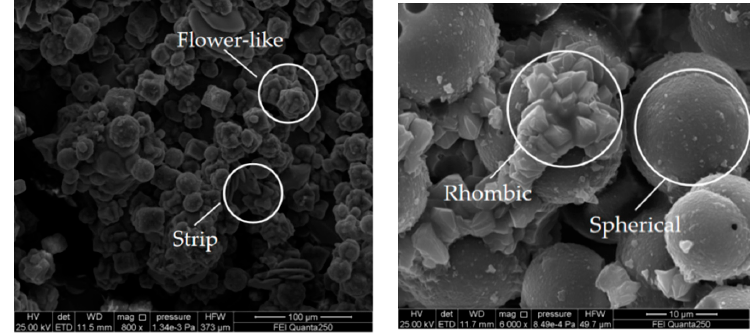
Figure 13. Moldy sample.